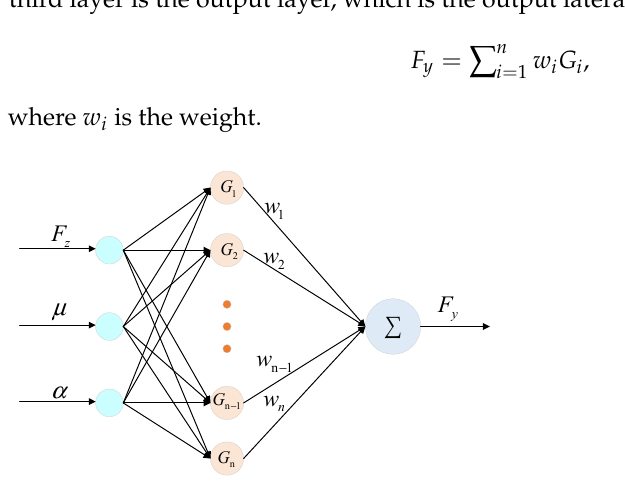
Figure 3. RBF neural network model for the lateral force.